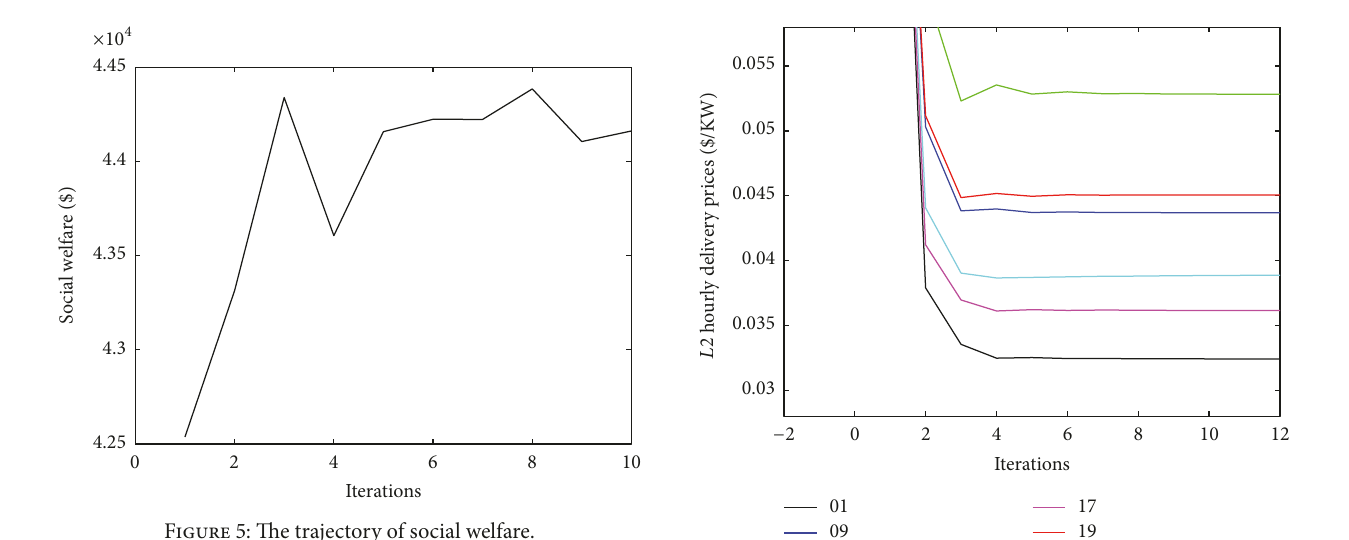
Figure 5: The trajectory of social welfare.